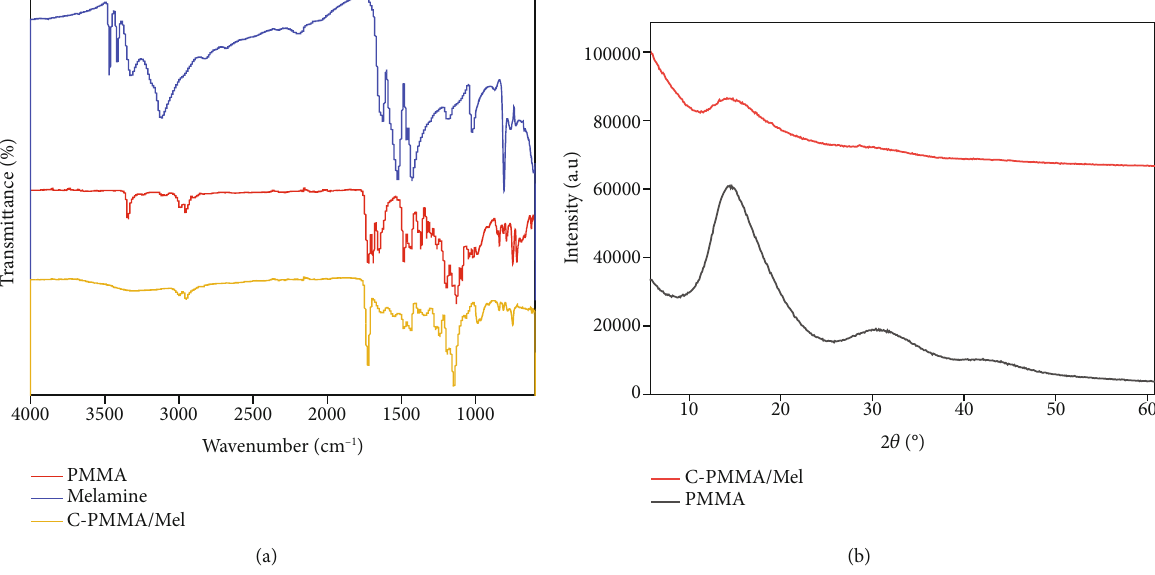
Figure 2: (a) FTIR spectra of the C-PMMA/Mel2. (b) XRD pattern of pure PMMA and the synthesized C-PMMA/Mel2. Table 2: Thermal properties of pure PMMA and C-PMMA/ Mel(1 –